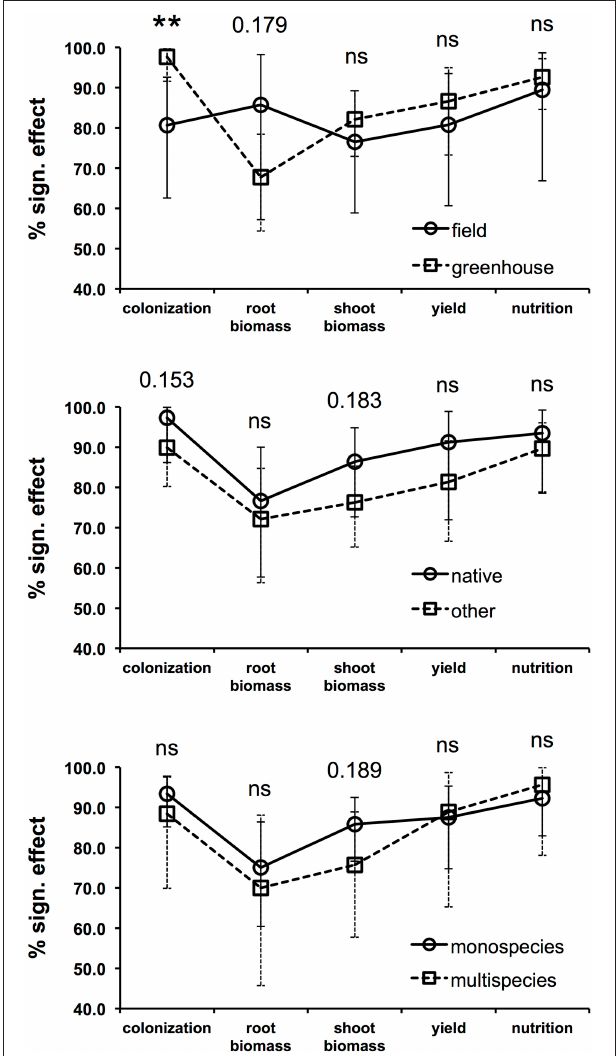
FIGURE 2 | Percentage of experiments showing significant increases in fungal colonization, root biomass, shoot biomass, yield, and plant nutrition comparing field and greenhouse conditions (upper graph), inoculation with native AMF and AMF of different origin (center graph), and inoculation with only one species and multiple species at the same time (lower graph). The statistical significance of the difference between the two proportions (percentage value divided by 100) calculated for each factor (i.e., cultivation condition, inoculant origin, and method of application) was computed with a series of 2-sample z -tests. The z -test p -value is reported for each of the five parameters in each graph ( ** p < 0.01 ; ns = p > 0.20 ). The asymptotic confidence intervals are reported for each percentage